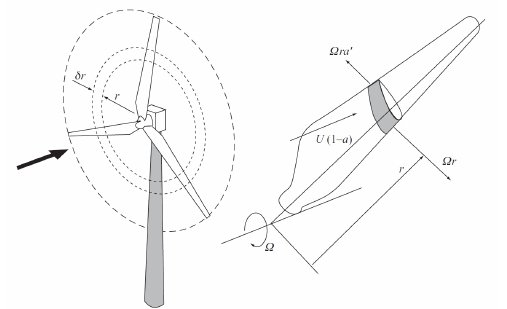
Figure 14. Blades subdivision as illustration to Glauert’s method [69].